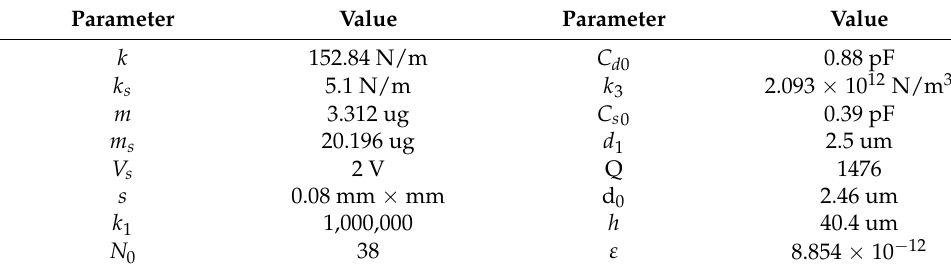
Table 2. Accelerometer structural parameters and circuit parameters.